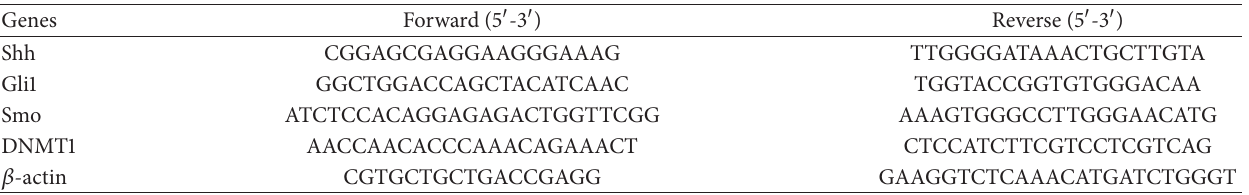
Table 3: Primer sequences for real-time